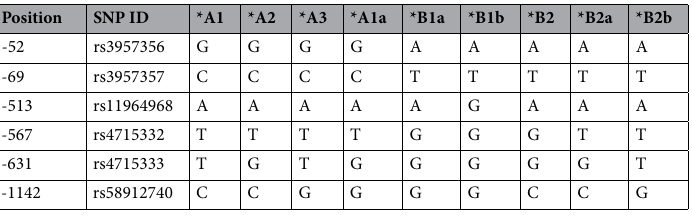
Table 1. Nine identified haplotypes in the 1000 Genomes Project population and their